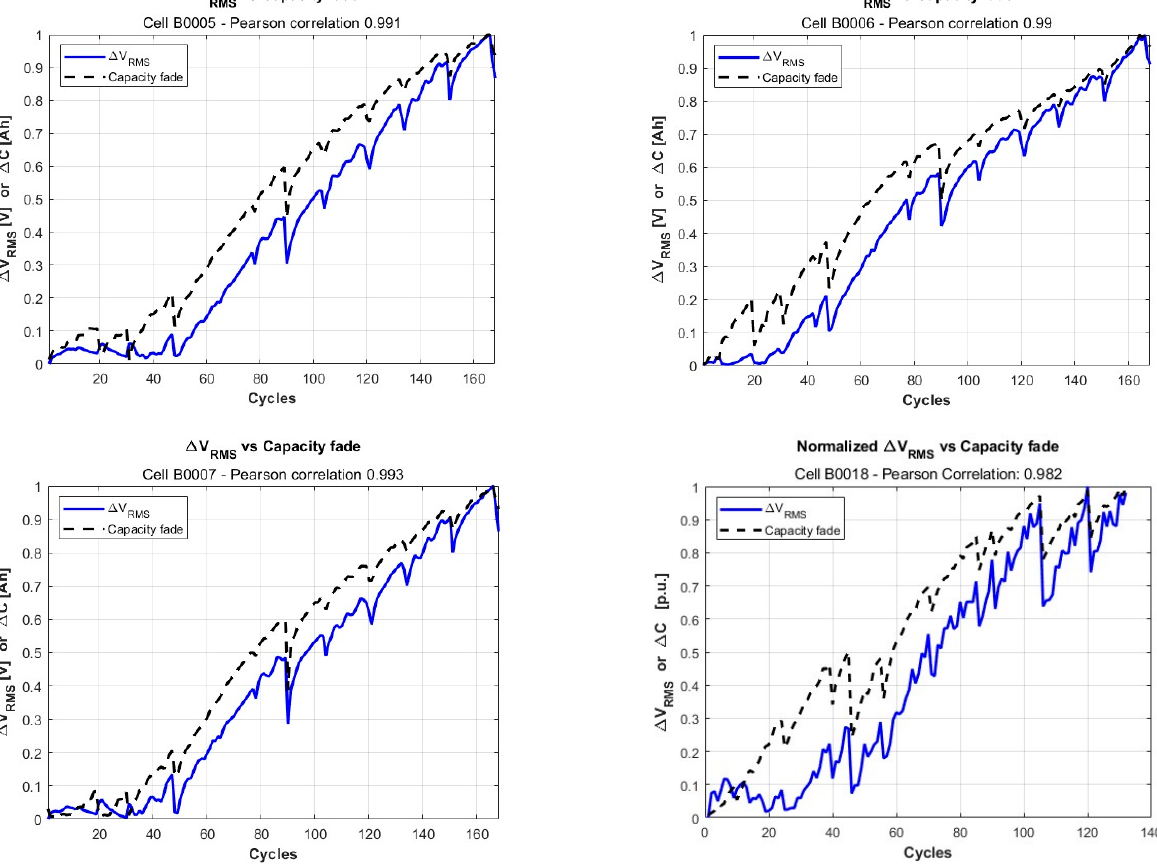
Figure 4. Capacity fade ∆ C and evolution of the proposed estimator ∆ V RMS for cell B0005 at a C-rate of 1.